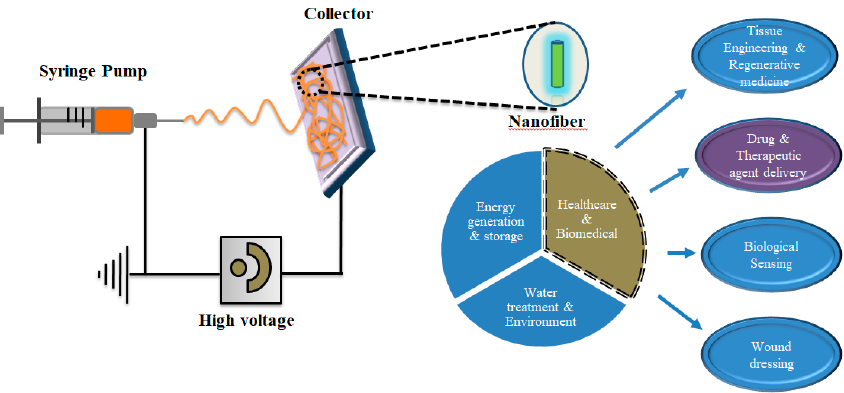
Scheme 2. Schematic illustration of a traditional electrospinning process and various healthcare and biomedical applications of nanofibers (reproduced from [142], MDPI 2019). biomedical applications of nanofibers (reproduced from [142], MDPI